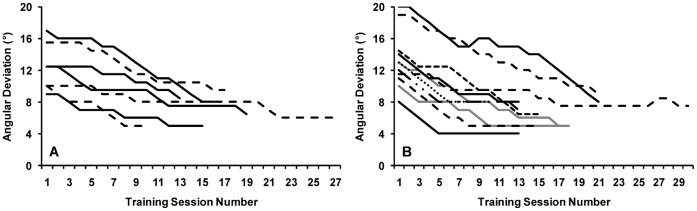
Improvement in behavioural thresholds as a result of learning for participants trained on in-phase dots (A) and counter-phase dots (B).Each training session consisted of 400 trials. If 75% correct or better was achieved during a training session, the angular deviation was decreased by 1° for the subsequent training session. For two participants trained on counter-phase dots, the angular deviation was increased for two sessions mid-training in an attempt to facilitate additional learning. Each line represents an individual participant.